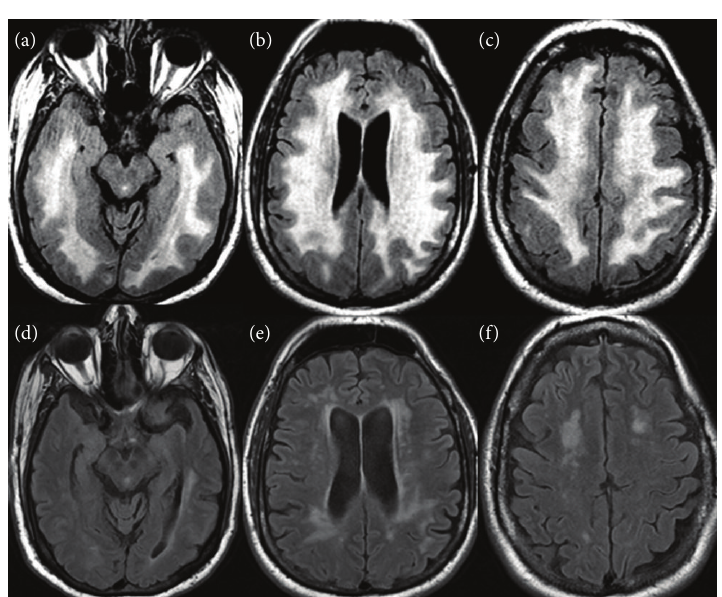
Figure 2: Magnetic resonance imaging findings in case 2 at initial presentation (upper row) and follow-up (lower row). (a)–(c) Axial FLAIR images, taken at the levels of the hippocampi, mid lateral ventricles, and centrum semiovale, demonstrate confluent areas of abnormal high signal in the deep white matter with sparing of the subcortical white matter and overlying cortex. (d)–(f) Axial FLAIR images, at similar levels to (a)–(c), demonstrate marked decrease in the abnormal signal in the cerebral white